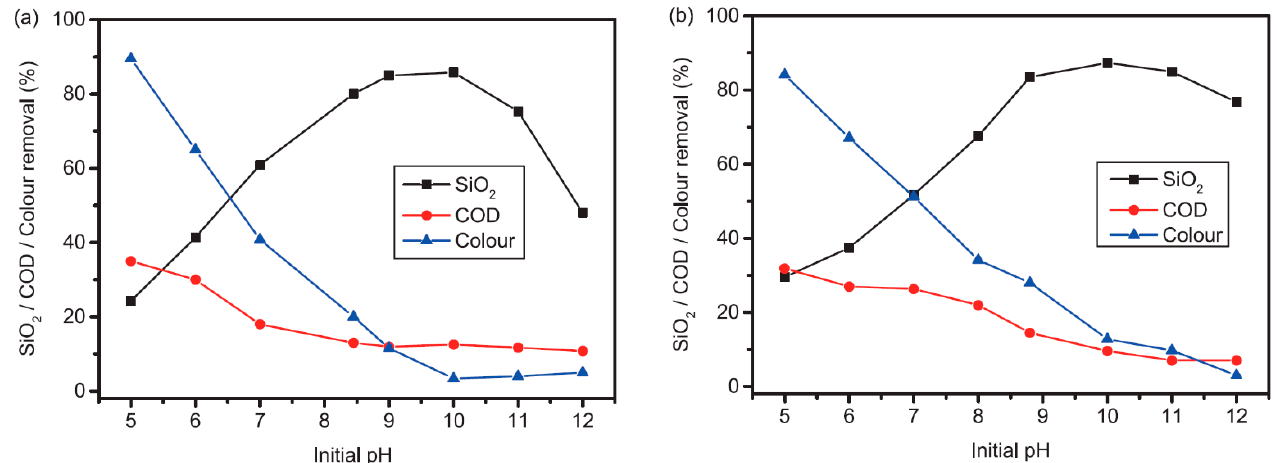
Figure 4. Effect of initial pH on silica, soluble COD, and color removal by ( a ) 15 g/L pseudoboehmite and ( b ) 5 g/L γ -Al 2 O 3 (experimental conditions: 20 °C, 4 h contact time).